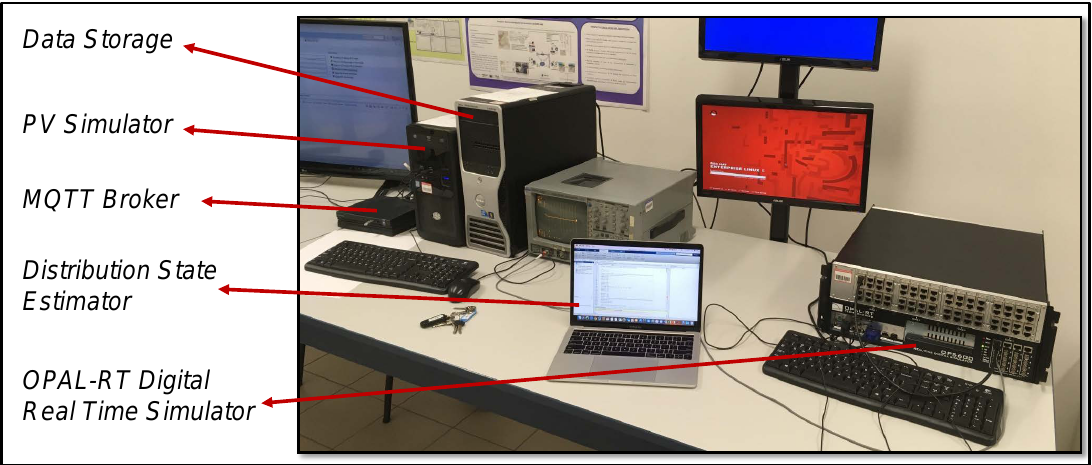
Figure 6. The lab set-up and platform